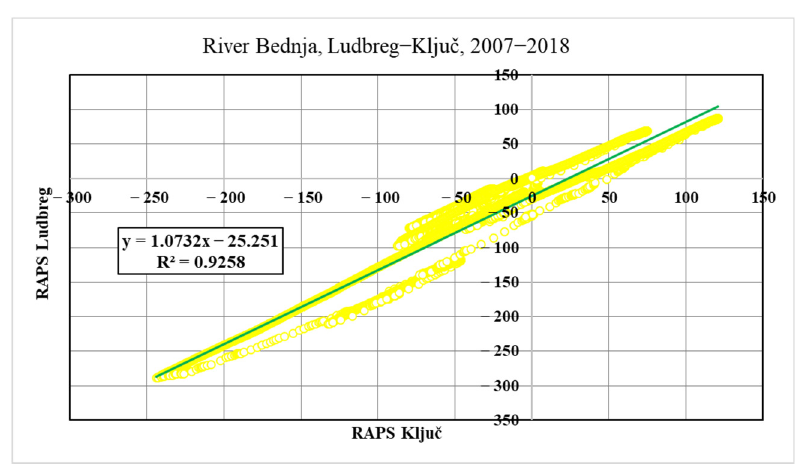
Figure 18. Correlation of RAPS values on Ludbreg and Klju č measurement stations.